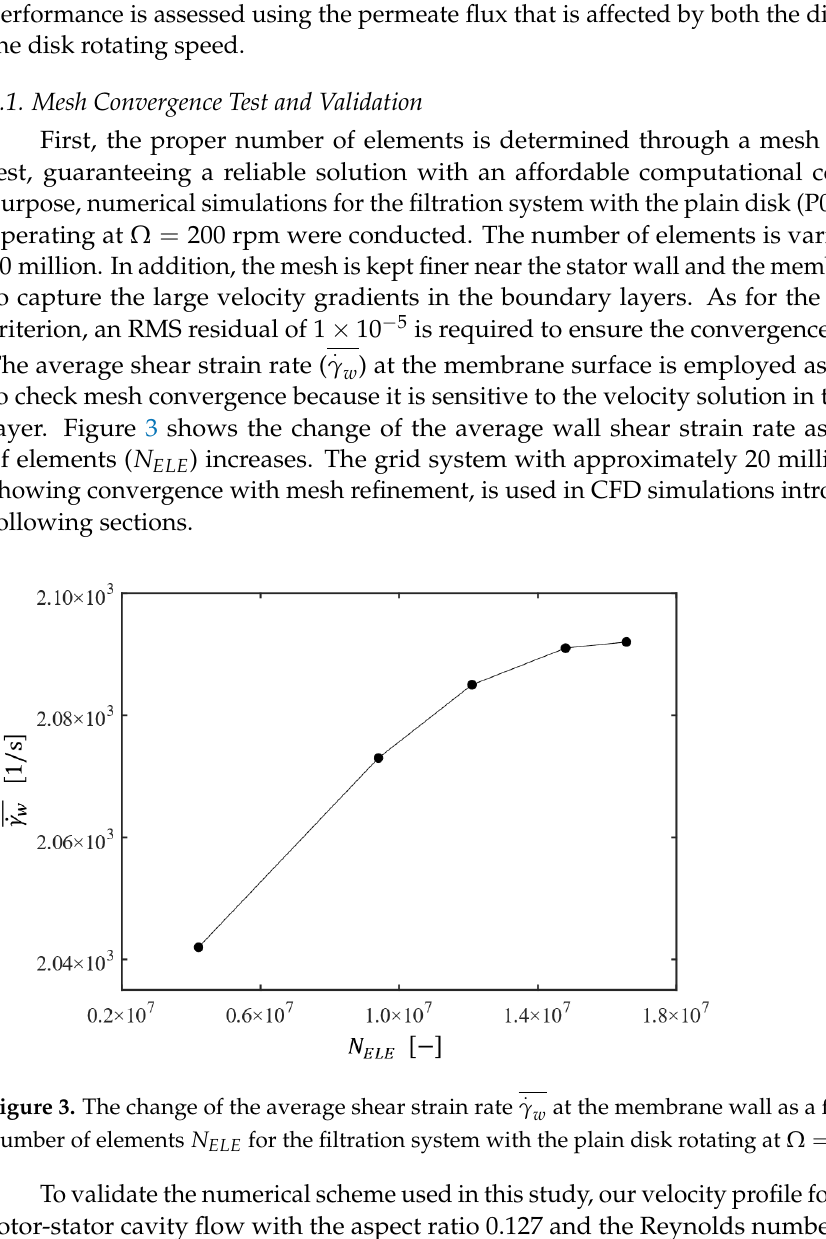
Figure 3. The change of the average shear strain rate number of elements N ELE for the filtration system with the plain disk rotating at Ω = 200